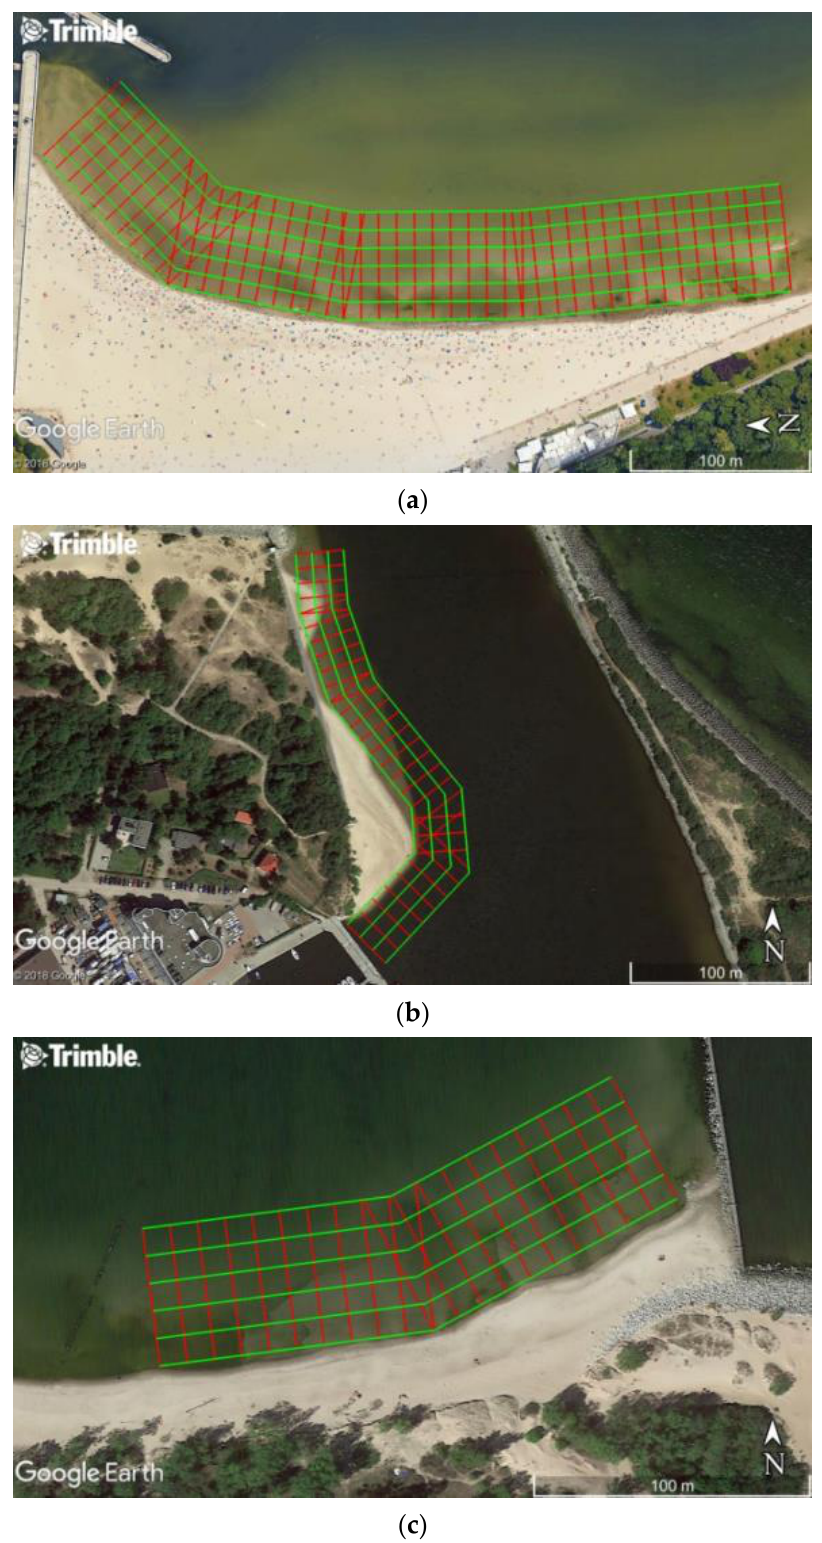
Figure 2. The sounding profile arrangement for representative waterbodies: ( a ) No. 1; ( b ) No. 2; ( c ) No. 3 [44].